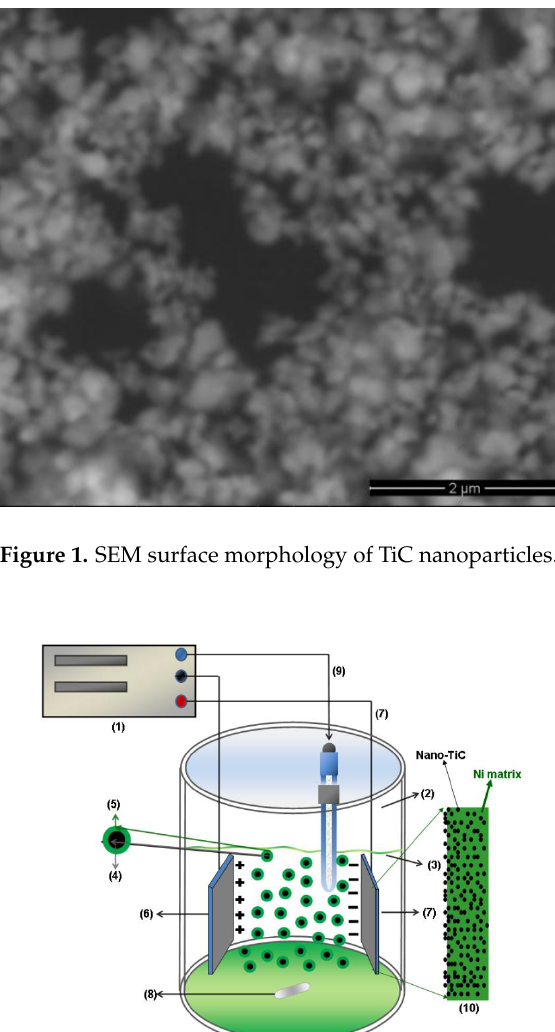
Figure 2. Schematic presentation of the electrolytic cell to obtain Ni/TiC nanostructured composite layers: ( 1 ) potentiostat/galvanostat; ( 2 ) electrochemical cell; ( 3 ) electrolyte; ( 4 ) nano-TiC (50 nm) dispersed particles; ( 5 ) ionic shell adsorbed around TiC particles; ( 6 ) anode (CE); ( 7 ) cathode (WE); ( 8 ) magnetic stirrer; ( 9 ) reference electrode (RE); ( 10 ) schematic representation of electrodeposited hybrid composite layer.